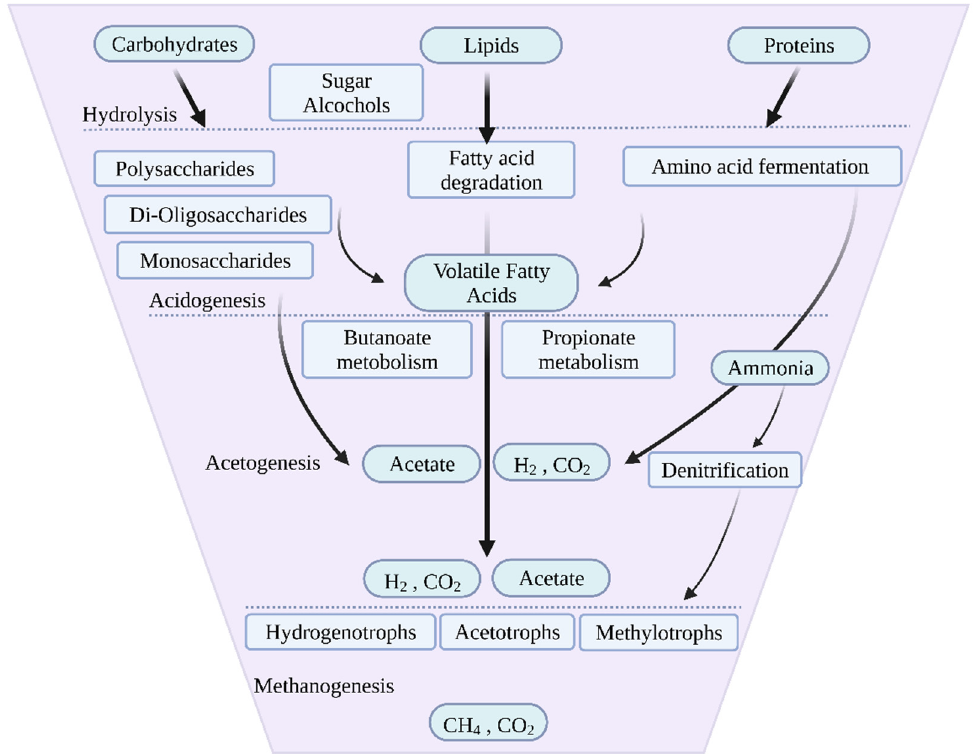
Figure 1. Anaerobic digestion fundamental steps of action, as modified from Campanaro et al. [40].